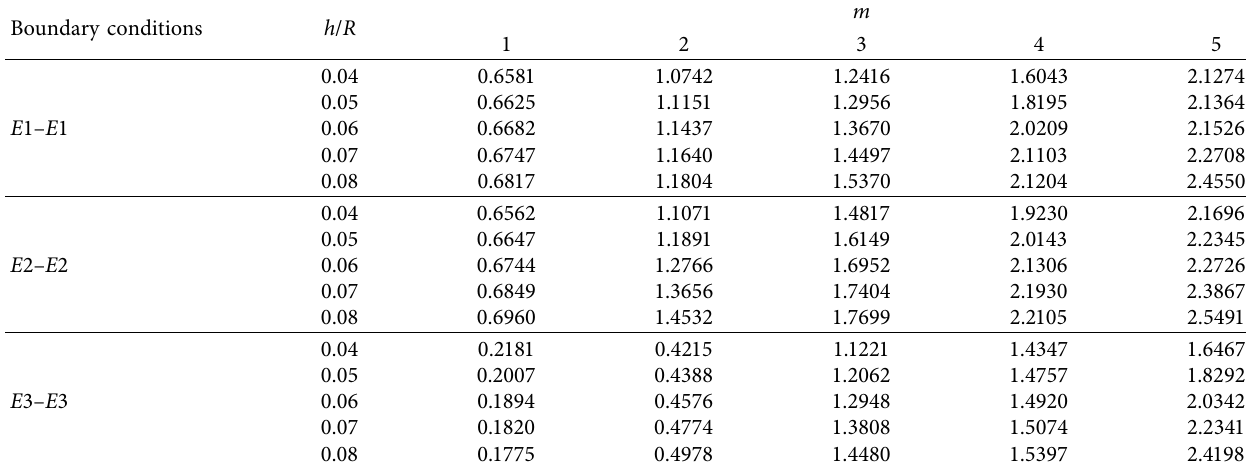
Table 7: Results of annular spherical shell with different h / R ratios ( φ Boundary